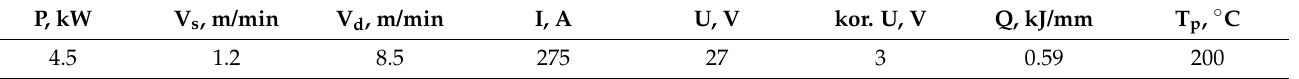
Figure 3. Position of the plates in the flat position (PA) according to the positions of the ISO standard. Table 3. Parameters of hybrid welding of S1300QL steel.